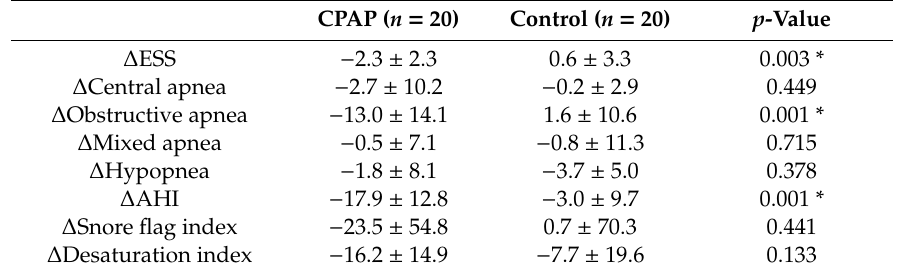
Table 4. Comparison of daytime sleepiness index and polysomnographic data between CPAP and control group.